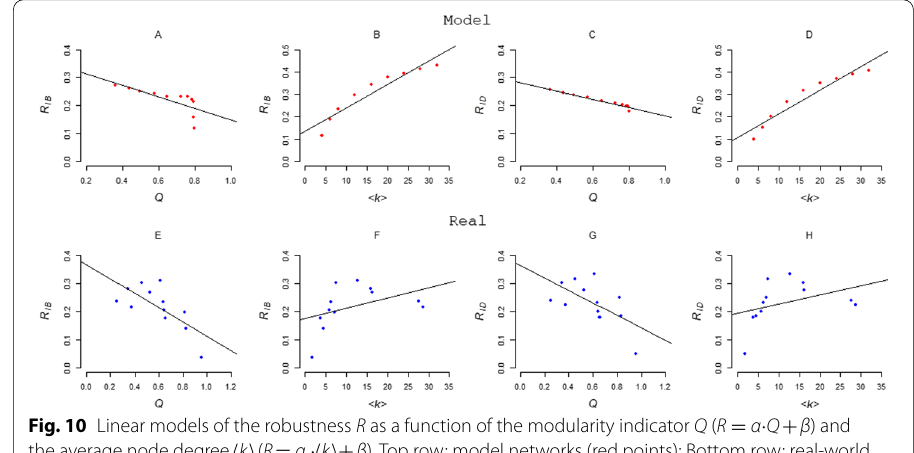
α Q β ) and = · + 10,000, (cid:31) k (cid:30) 4, m 5 and with = = = 10,000, =